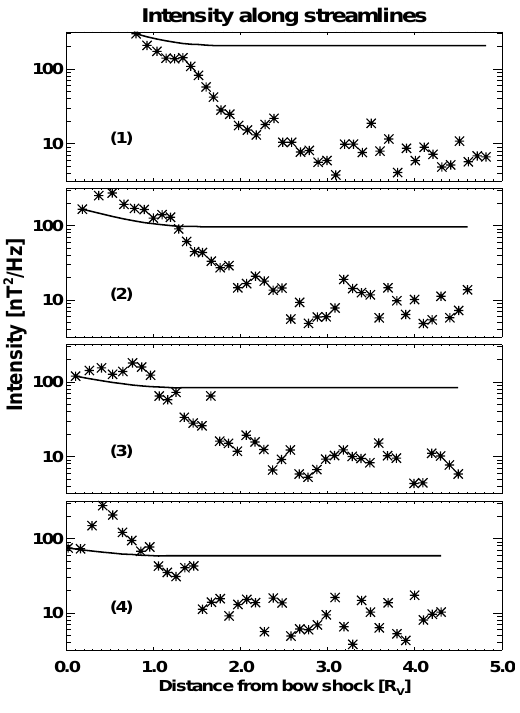
Fig. 10. Evolution of the intensity along different streamlines (the numbers (1) to (4) in the panels correspond to the streamlines in Fig. 9). The solid line denotes the calculated intensity function de- rived from the continuity equation (Eq. 9), while the asterisk sym- bols denote the observed